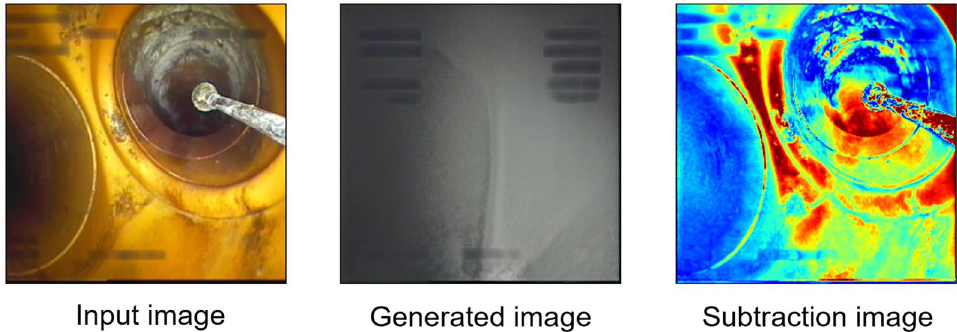
Fig. 25 Example of difficulties in detecting